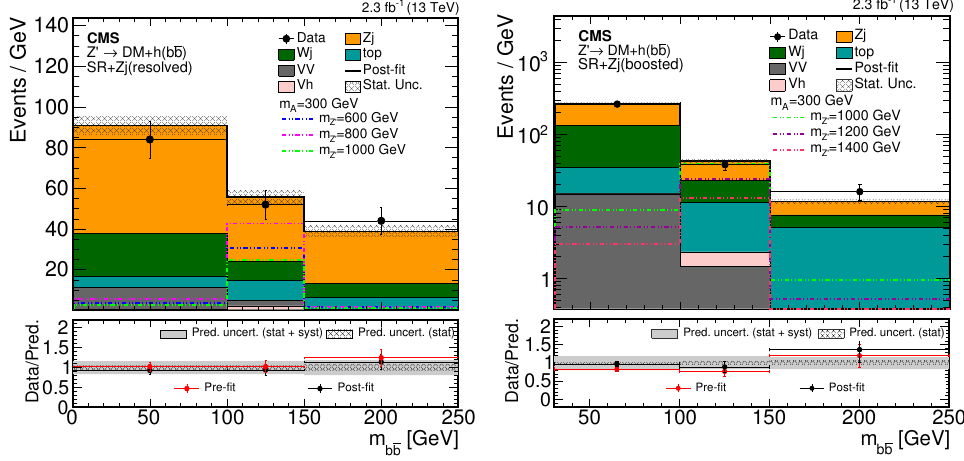
Figure 3 . Post-(cid:12)t distribution of the reconstructed Higgs boson candidate mass expected from SM backgrounds and observed in data for the resolved (left) and the boosted (right) regimes with three di(cid:11)erent m Z 0 signal points overlaid. Other parameters for this model are (cid:12)xed to m (cid:31) = 100 GeV and tan (cid:12) = g (cid:31) = 1. The cross sections for the signal models are computed assuming g Z 0 = 0 : 8. The bottom panels show the data-to-simulation ratios for pre-(cid:12)t (red markers) and post-(cid:12)t (black markers) background predictions with a hatched band corresponding to the uncertainty due to the (cid:12)nite size of simulated samples and a gray band that represents the systematic uncertainty in the post-(cid:12)t background prediction (see section 6). The second bin represents the SR, while the events in the (cid:12)rst and third bins are merged and represent the mass sidebands (Z( ! (cid:23)(cid:23) )+jets) CR.